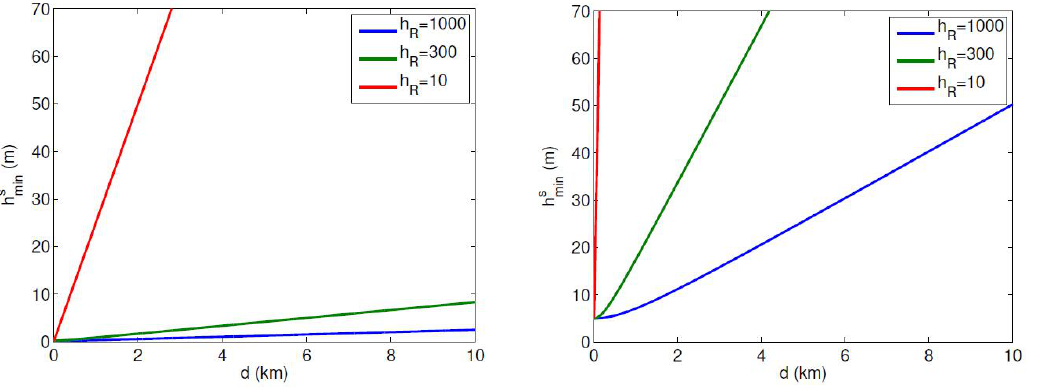
Figure 4. h min for δ r = 0.5 m ( left ) and δ r = 10 m ( right S